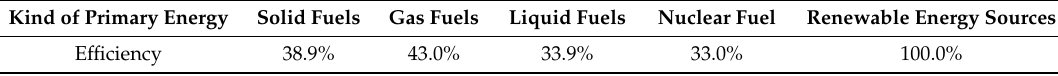
Table 3. Comparison of energy conversion e ffi ciency for particular